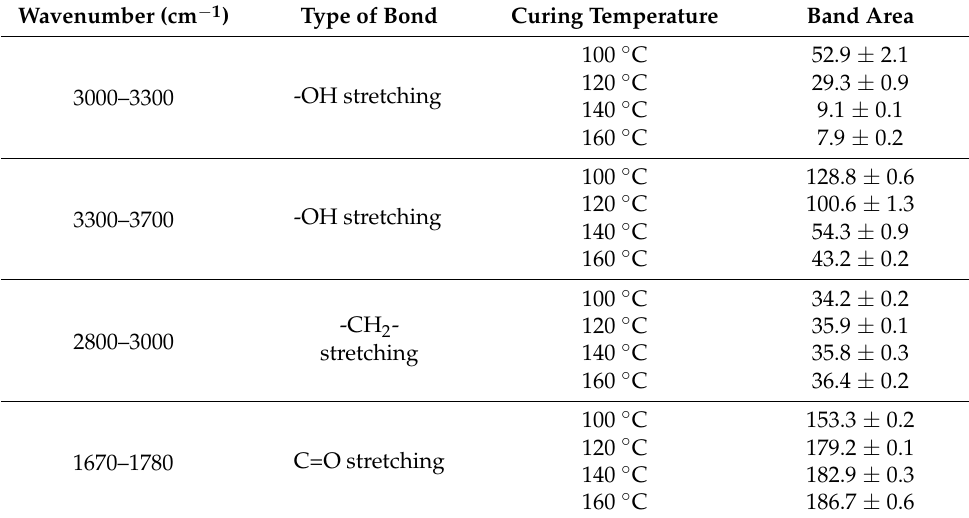
Figure 10. FTIR spectra: Citric acid and Grape cane extract GCE1 cured with citric acid (43% on adhesive weight, dry basis) at 100–180 °C (600–1800 cm − 1 ). The changes of the main bands in the polymerization process are shown in Table 7. Table 7. Polymerization degree for the GC E1 + CA (43% on adhesive weight, dry basis), cured at 100–160 °C during 120 s.